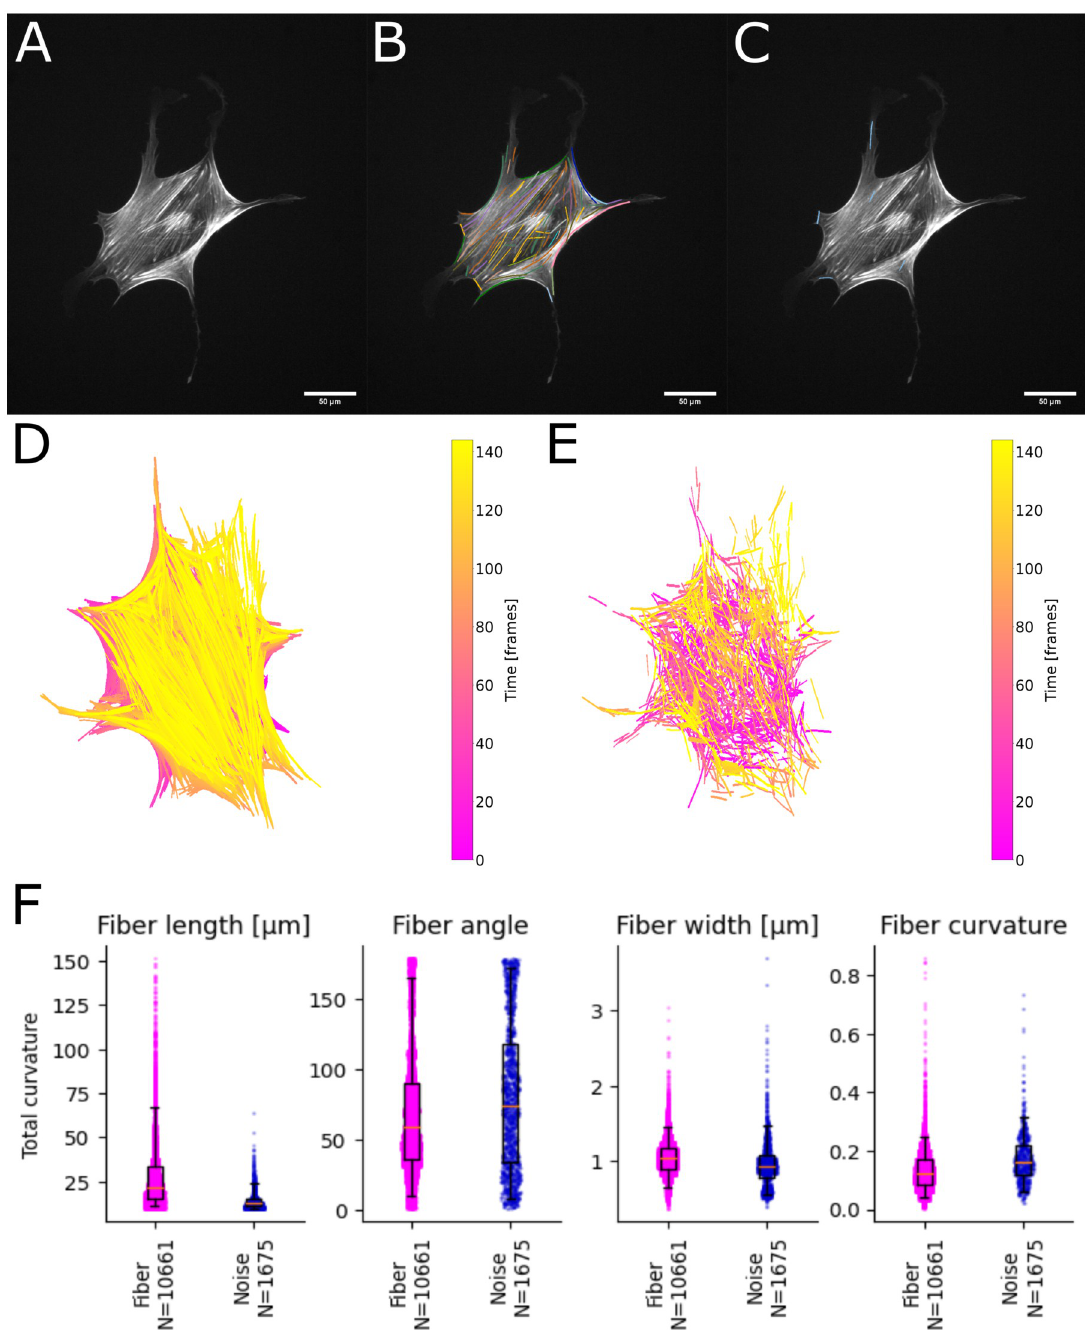
Fig 4. Single filament tracking. A : Original image of hMSC on collagen-I coated glass, 15 hours after seeding. B : Filaments found in the example frame with lifetimes longer then 4 frames randomly color-coded. C : Filaments found with the single filament tracking plugin in the example frame with lifetimes of only one frame. D : Overlay of all filaments with lifetimes larger then 4 frames color-coded for frames. E : Overlay of the noise with lifetime of one frame color-coded for frames. F-I : Comparison of trusted filaments versus noise for: F : length, G : width, H : angle, and I : curvature. We performed a Kolmogorov–Smirnov test between each pair of conditions. All p-values are <